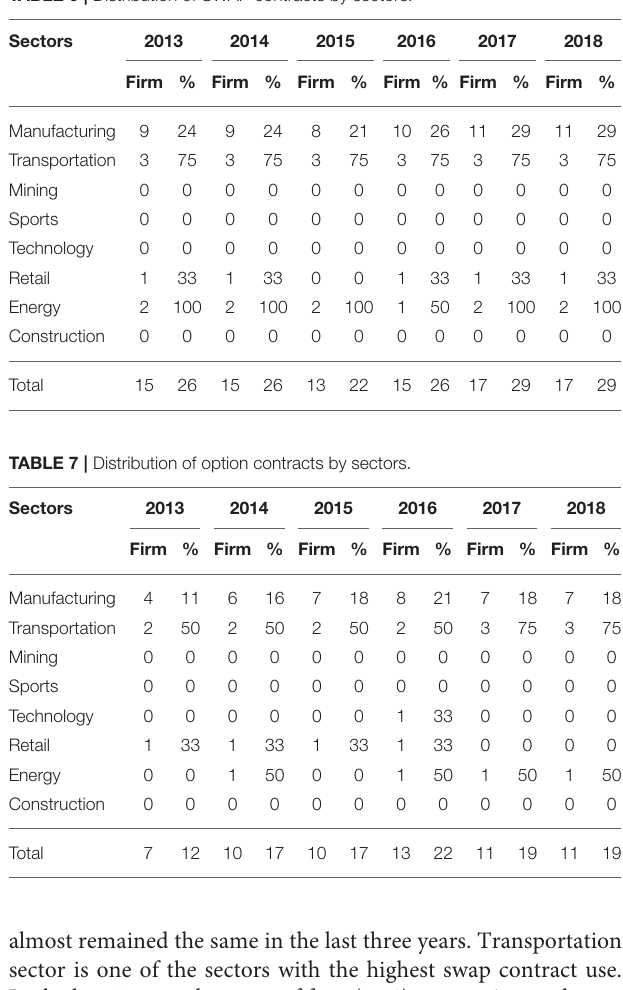
TABLE 6 | Distribution of SWAP contracts by sectors.